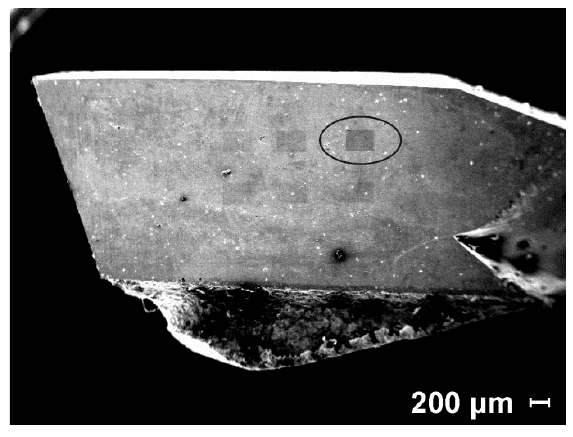
Figure 8. EDS tests on the tooth surface.